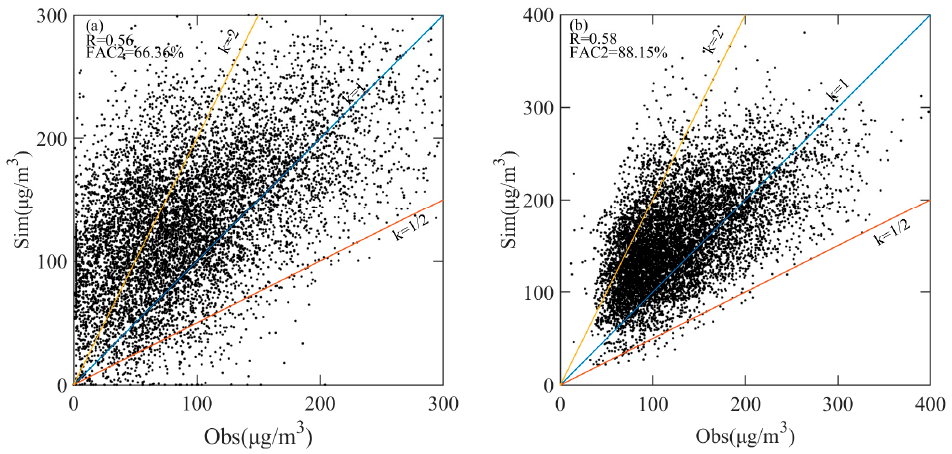
Figure 4. Scatter plots for the comparison of observed and simulated O 3 ( a ) and O X ( b ) with the statistical parameters R and FAC2; the 2:1 line (yellow), 1:1 line (blue), and 1:1/2 line (red) are also shown.